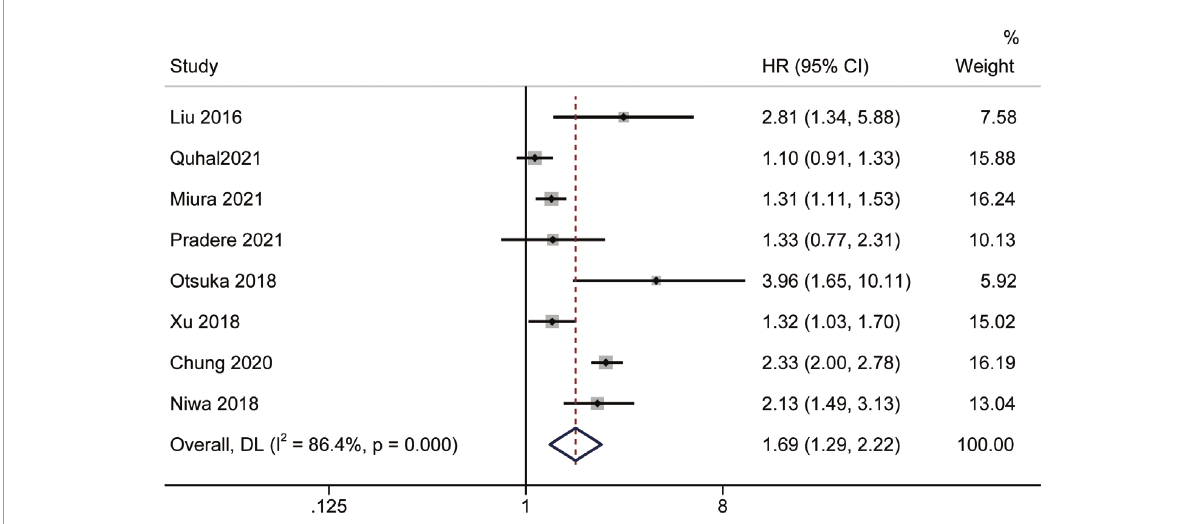
FIGURE6 Forest plot reflects the association between AGR and RFS for urological cancers.